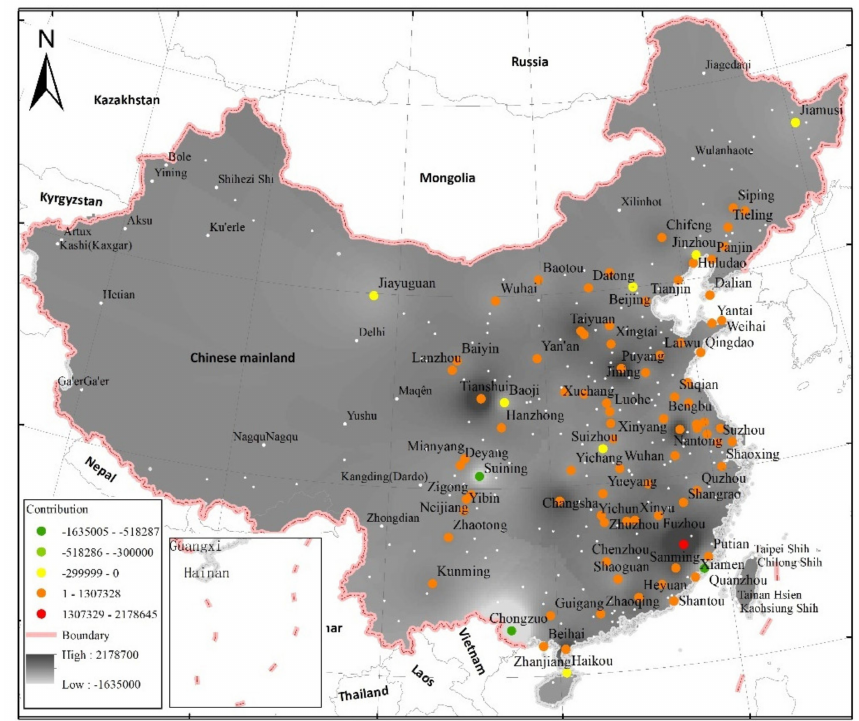
Figure A2. Contribution from the indicator PPMC (population proportion of municipal to city) to land-use intensity revealed in the city-based assessment.